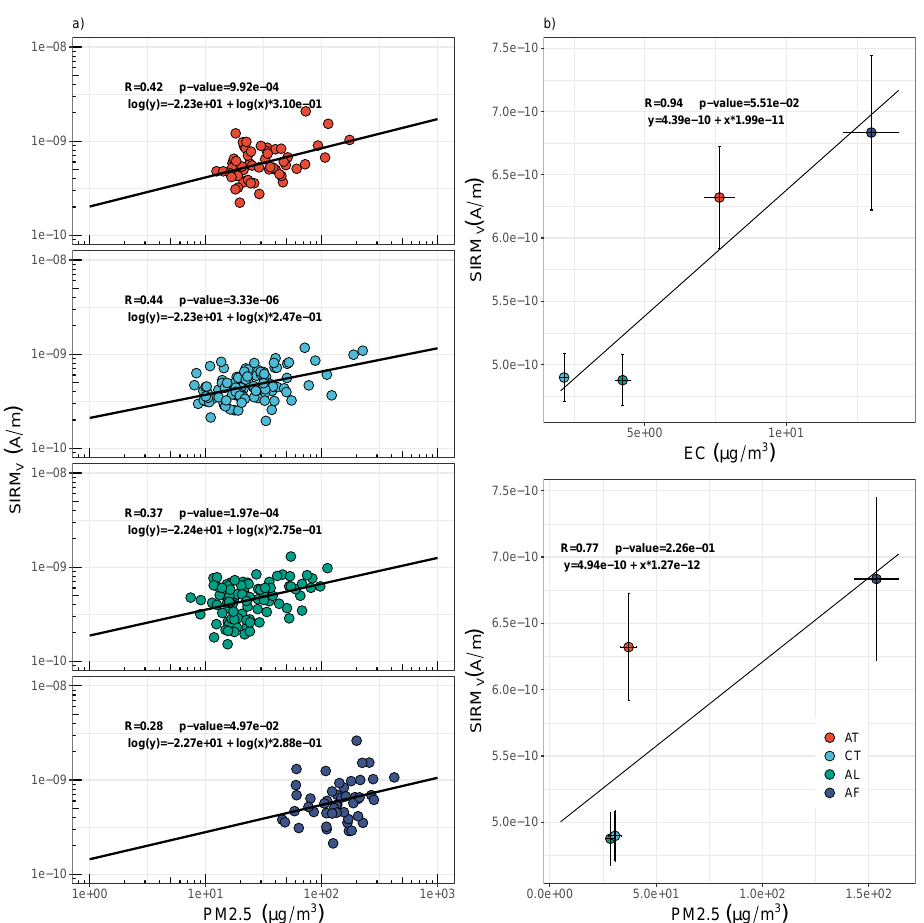
Figure 3. ( a ) Weekly values of SIRM V versus PM2.5 concentration for each site. ( b ) Correlation between SIRM V means and EC and PM2.5 concentrations means for the whole data series in each site. Error bars are the standard